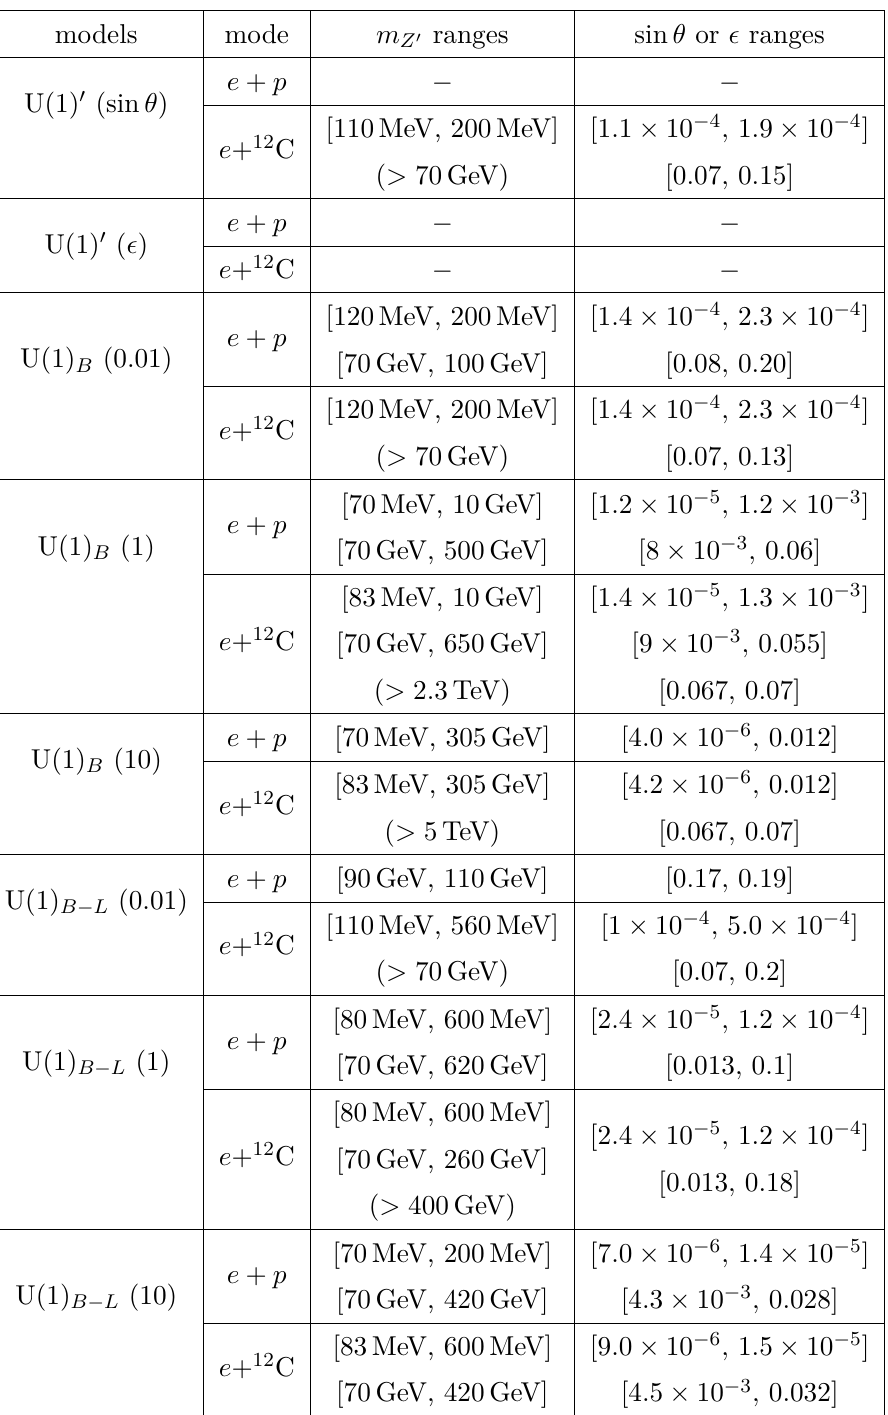
Table 5 . Similar to table 4 except for non-chiral U(1) 0 models, summarized from figures 3 to 6. The columns of U(1) 0 ( sin θ ) in the e + p mode and U(1) 0 ( (cid:15) ) for all models are void because P2 does not have better sensitivities than the existing